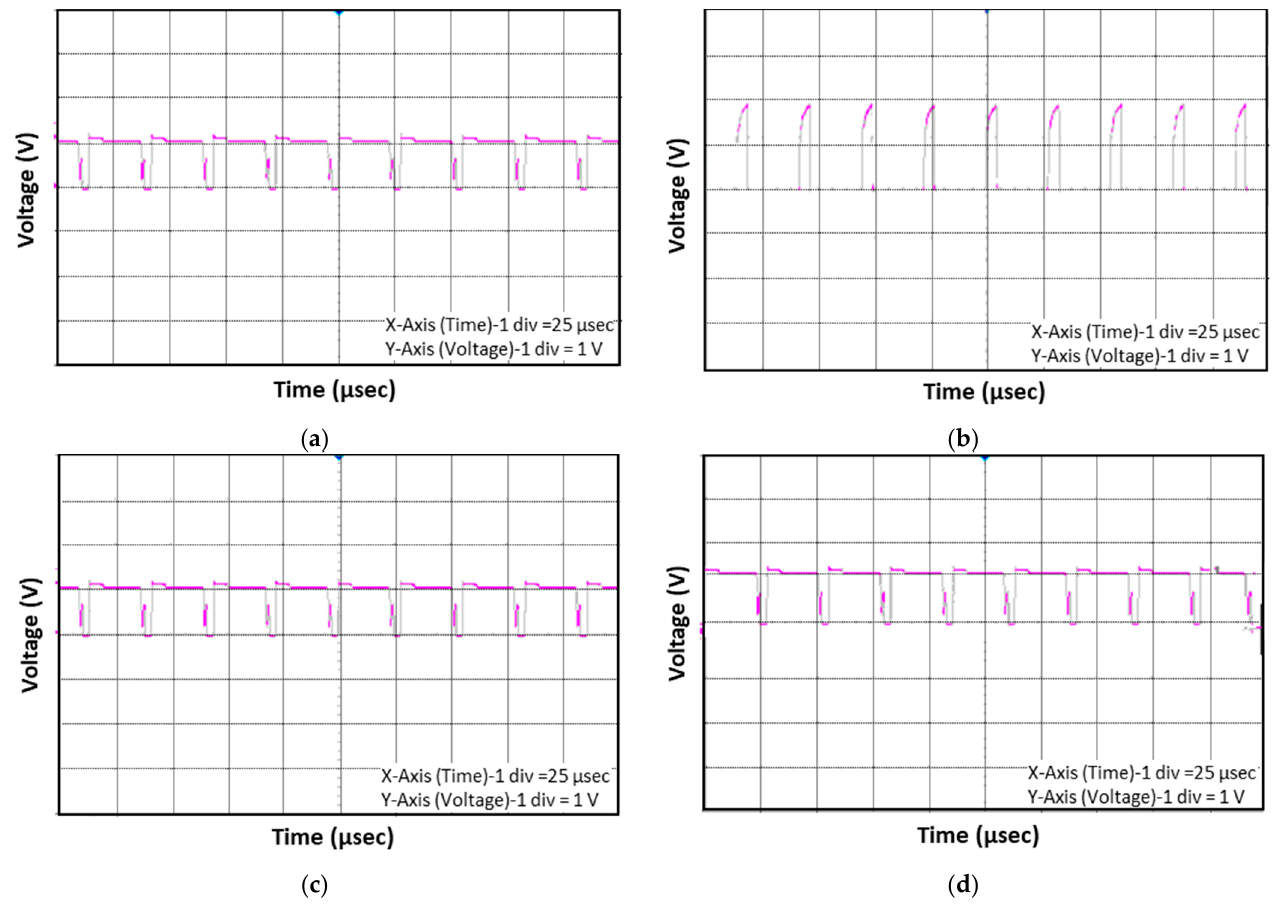
Figure 15. Pulse generated for ( a ) Switch S 1 ; ( b ) Switch S 2 ; ( c ) Switch S 3 ; and ( d ) Switch S 4 . The switches were operated at a switching frequency of 25 kHz. The voltage across the inductors L 1 and L 2 are shown in Figure 16a,b, in which the plot is obtained for a scale of 25 V/div. The inductor L 1 charged and discharged to its input voltage from the PV source of 40 V. The voltage across the capacitor C 1 initially charged to a value equal to the input voltage and discharged to maintain a constant output voltage, thus maintaining at − 70 V as shown in Figure 16c. Figure 16d shows that capacitor C 2 charged to a voltage equal to the battery voltage of 40 V, since C 2 was connected to the KY part of the MPC in which battery acted as the input source.